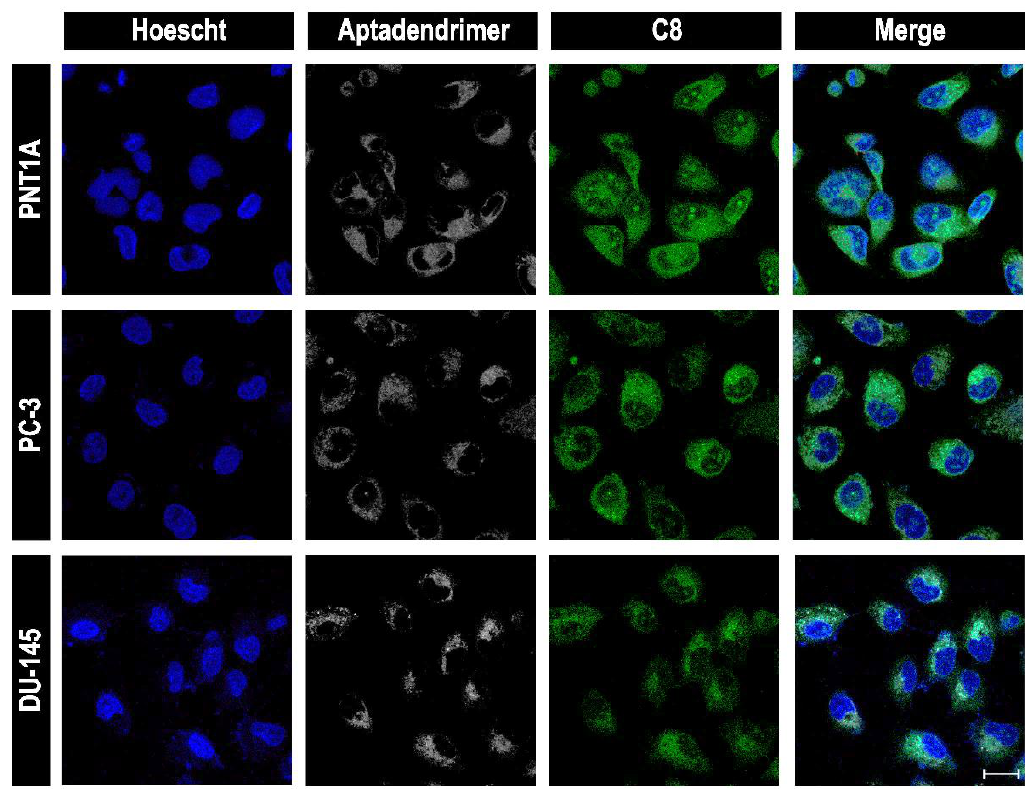
Figure 8. Confocal laser scanning microscopy of prostate cells (PNT1A, PC-3, and DU-145) incu- bated 1 h with the C 8 –aptadendrimer complex. Results evidenced that the aptadendrimer and C 8 –aptadendrimer complex is able to enter into all cell lines. Additionally, colocalization among the aptadendrimer and C8 was observed which demonstrates the formation of a complex in cellulo. Cy5-labelled aptadendrimer is represented as a white signal and the C 8 ligand as green fluorescence. Cell nuclei are stained with Hoechst 33,342 (blue signal). Scale bar: 20 µm.